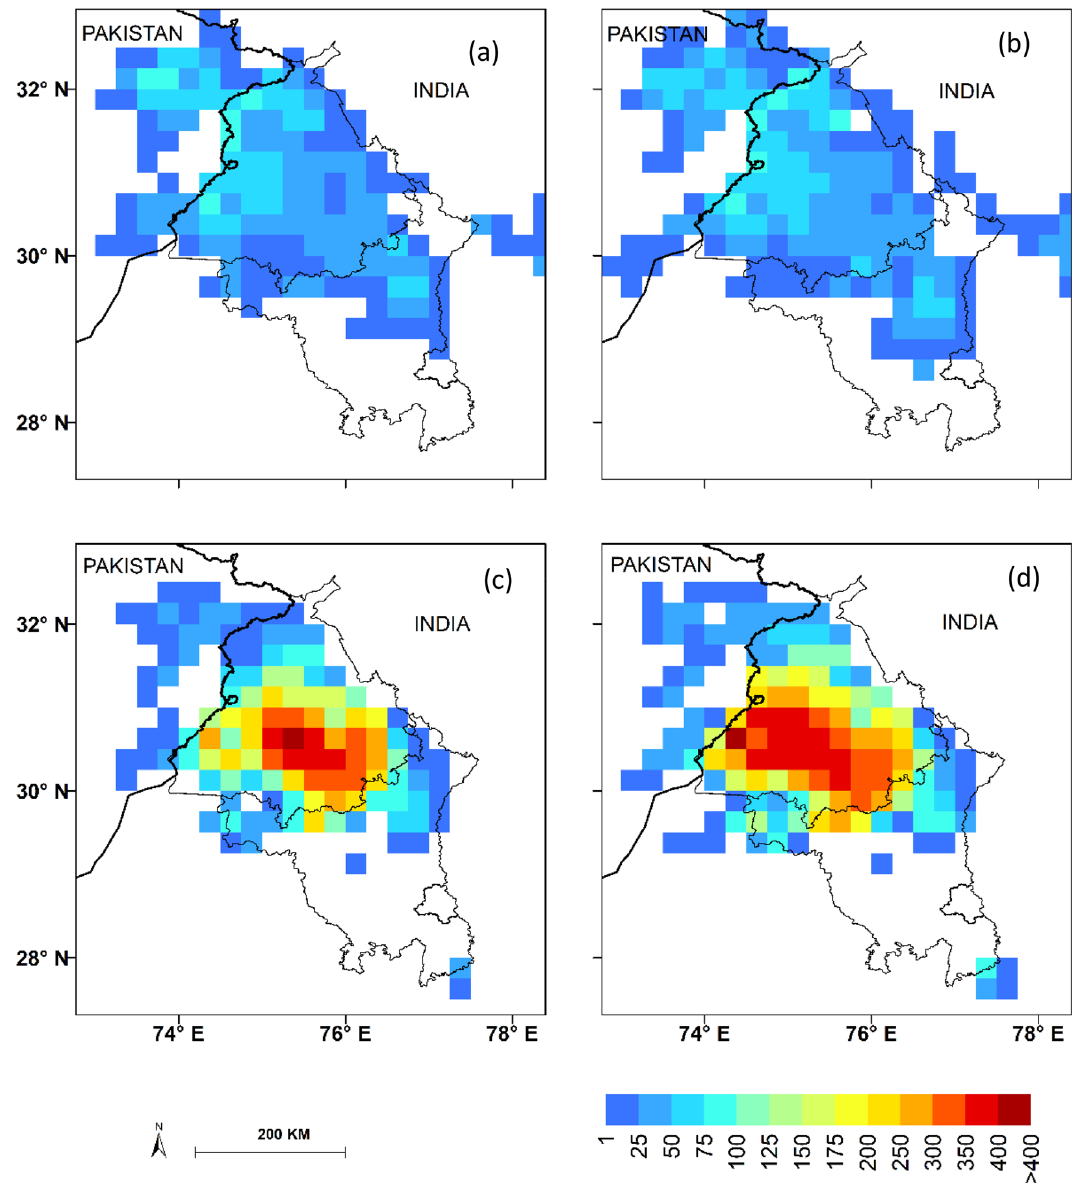
Figure 2. Fire density (no. of fires per day at 0.25 × 0.25° grid) for pre-2010 era (left panel) & post-2010 era (right panel); ( a , b ) PrM SB and ( c , d ) PoM SB , respectively. The maps are generated using licensed software ArcGIS version